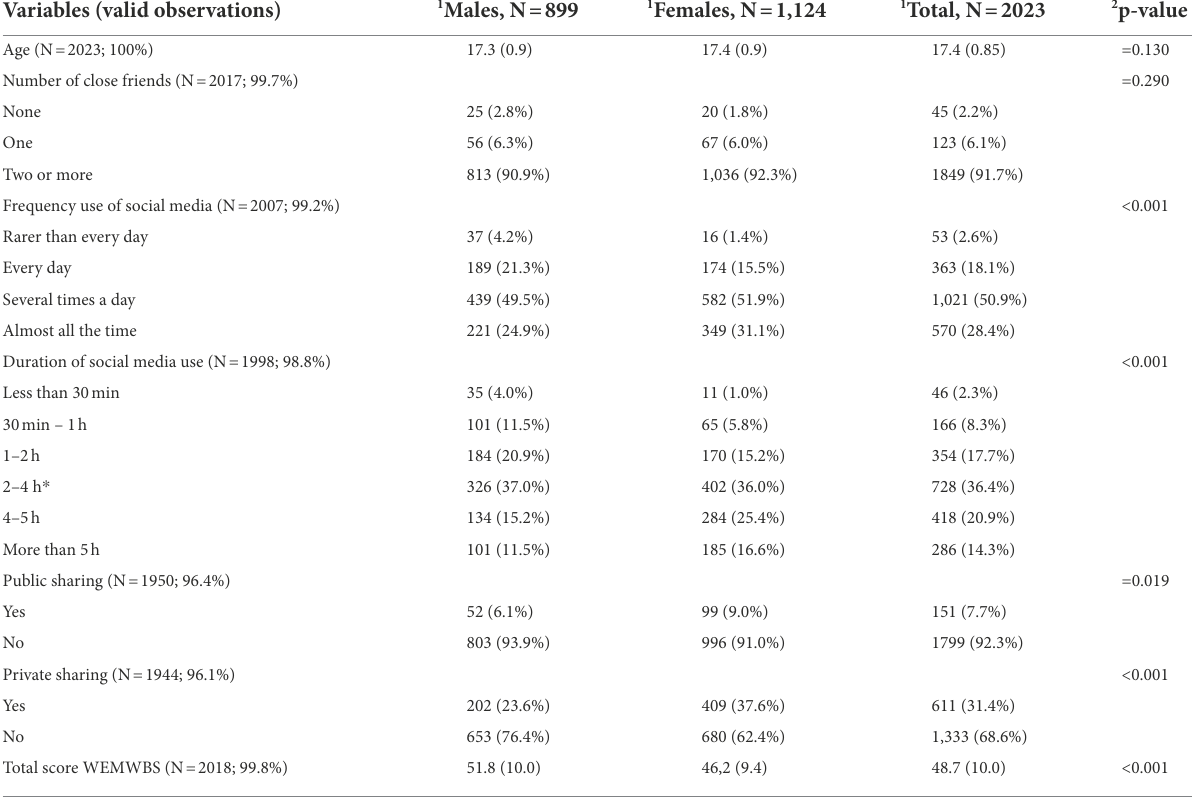
TABLE 1 Descriptive statistics comparing gender for both control and main